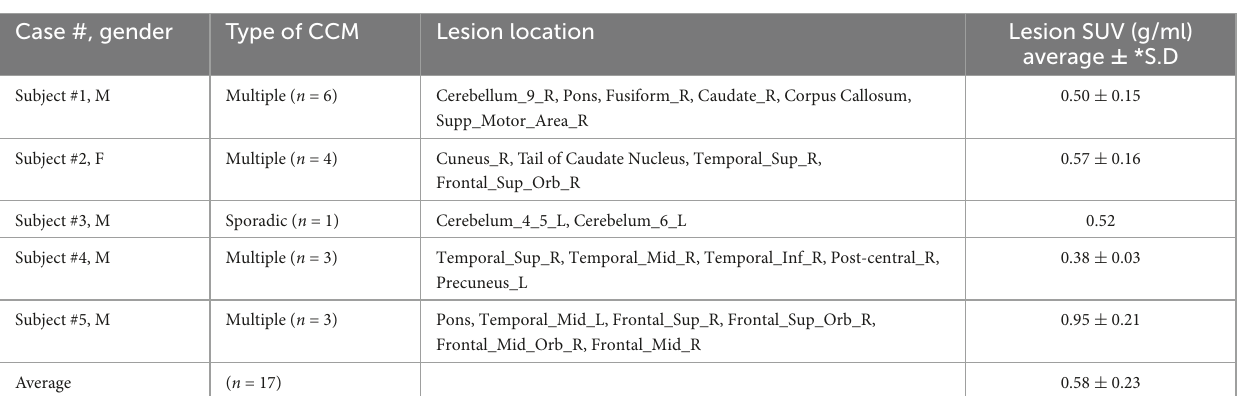
TABLE 3 Each CCM subject’s lesion type, CCM location, flutriciclamide uptake, and SUVs.